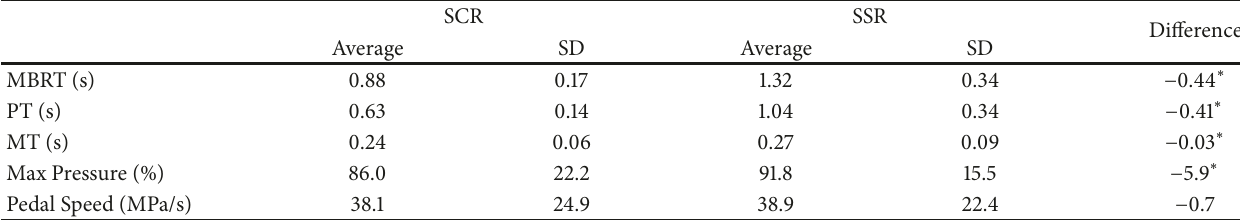
Table 8: Summary of drivers’ braking features in SCR and SSR